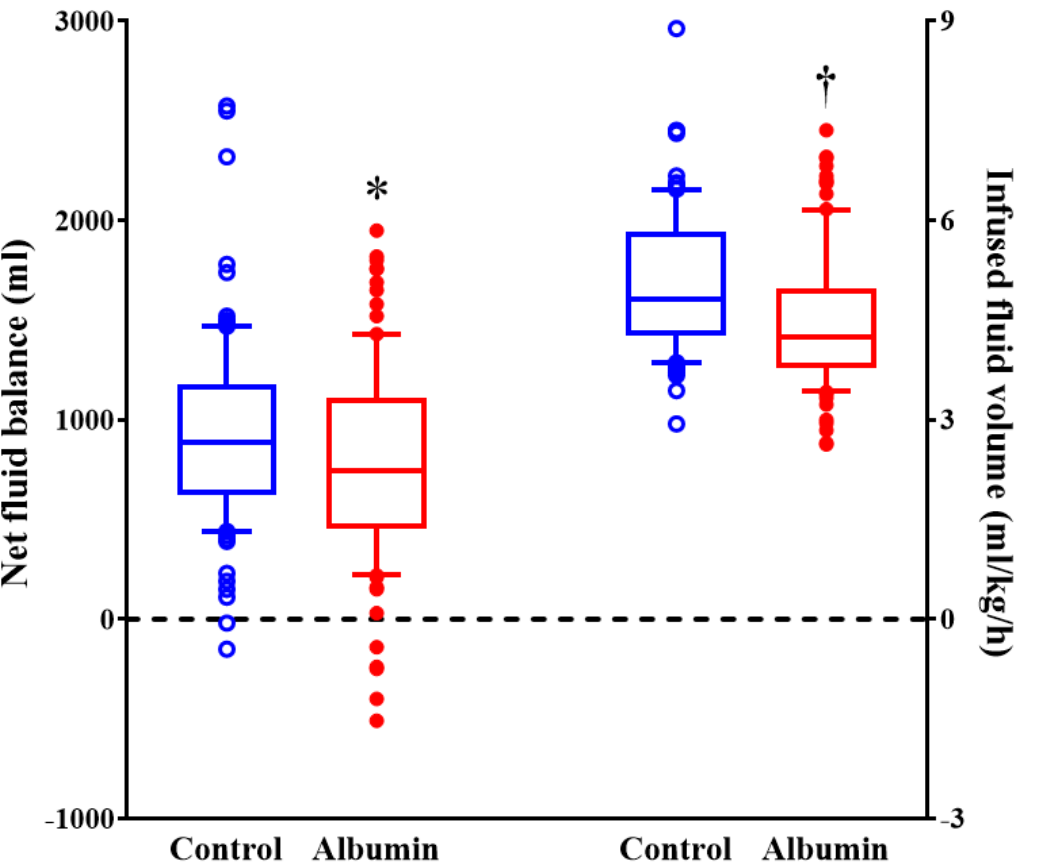
Figure 2. The volume of intraoperative fluid during pancreatectomy. Horizontal lines, boxes, and error bars represent the median, interquartile range, and outliers, respectively. * p = 0.03 versus control group. † p < 0.001 versus control group.